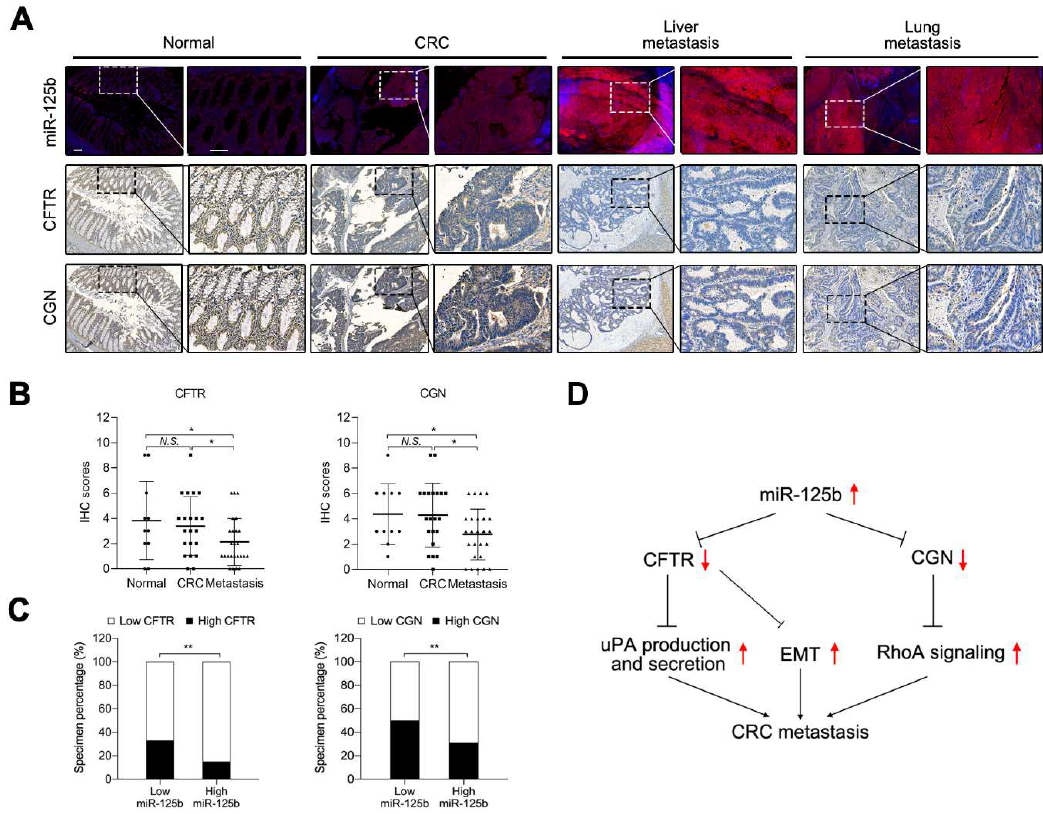
Figure 8. miR-125b is negatively correlated with CFTR and CGN in CRC. ( A ) Representative images of serial sections indicate an inverse relationship between miR-125b and both CFTR and CGN. Magnified views of the regions indicated by the boxed area are shown below. Scale bars represent 200 μm (up) and 100 μm (down). ( B ) CFTR and CGN levels were decreased in metastasis compared with normal and CRC tissues. Left: p = 0.6545 (Normal vs. CRC); p = 0.0494 (Normal vs. Metastasis) p = 0.0472 (CRC vs. Metastasis); Right: p = 0.9330 (Normal vs. CRC); p = 0.0443 (Normal vs. Metastasis) p = 0.0269 (CRC vs. Metastasis). ( C ) The association between miR-125b expression and CFTR and CGN levels in CRC specimens. * p < 0.05, ** p < 0.01 by Wilcoxon signed rank test in ( B ) and by Chi-square test in ( C ). ( D ) A picture summary of our results.